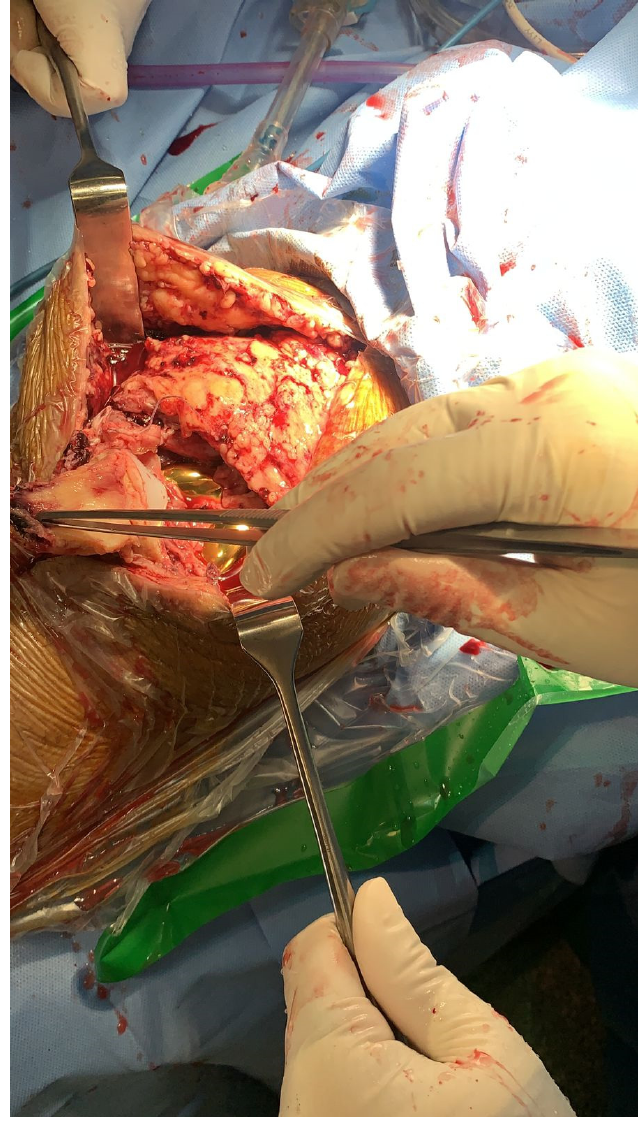
Figure 6. Demonstrating quadriceps rupture intraoperatively .